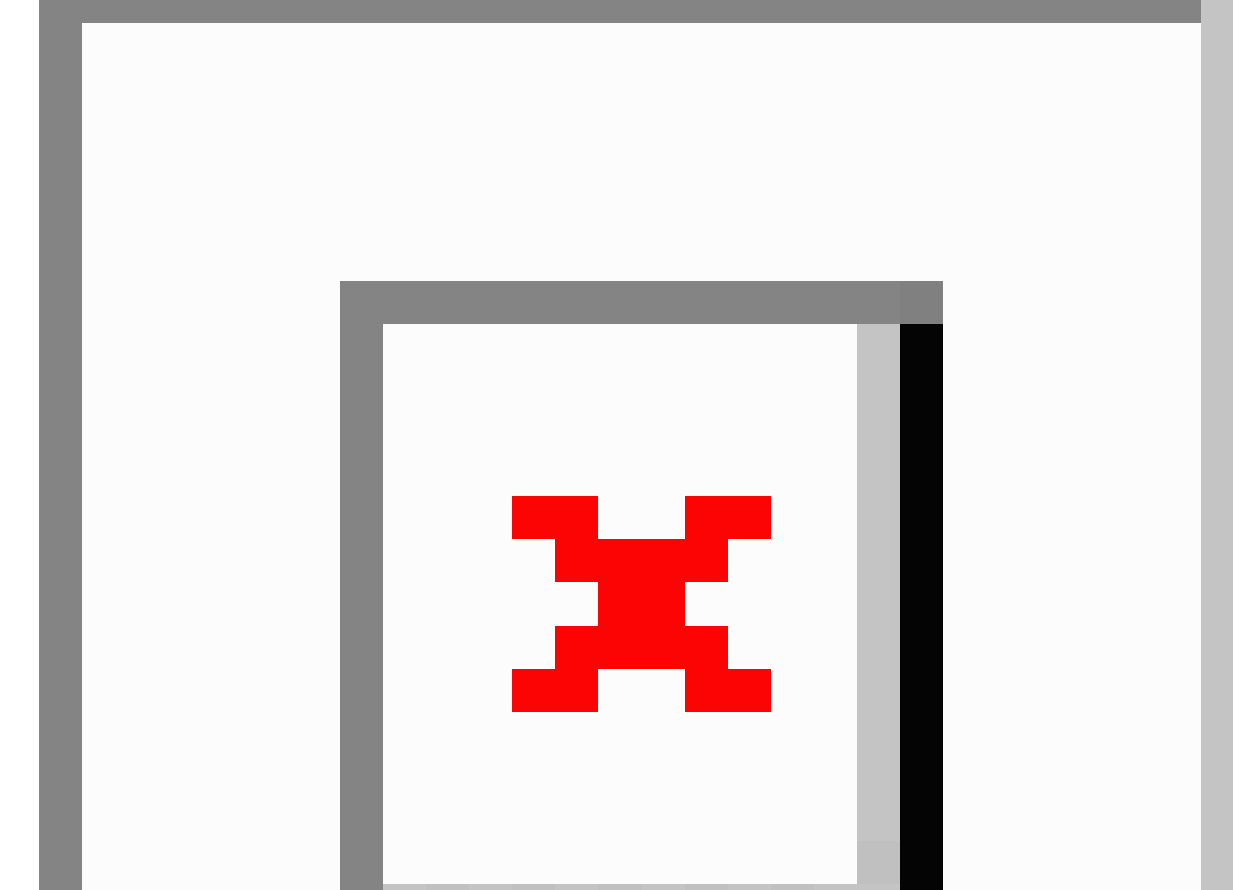
Figure 6. (a) Example of composition by visual similarity: eye drops; (b) Example of composition by semantic association: dry mouth; (c) Example of composition by convention: